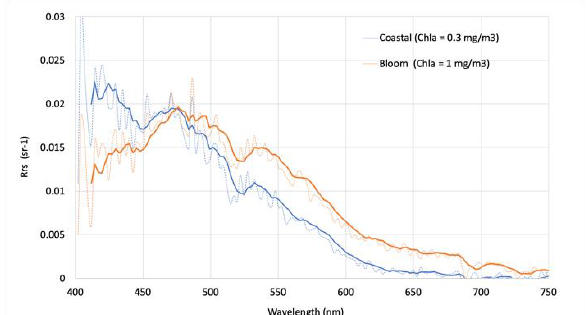
Figure 9 . True colour composite of DESIS Level 1 (left) and the retrieved chlorophyll-a concentration (mg/m 3 ) with Polymer at the Lucinda AERONET-OC study region for DESIS and S2- Figure 6 . True colour composite of DESIS Level (left) and the MSI in 25.12.2019. Grey and white regions are masked as in retrieved chlorophyll-a concentration (mg/m 3 ) with Polymer at Figure 3. the Galata AERONET-OC study region in 13.02.2020. Grey and white regions are masked as in Figure 3. Black dots indicate A quick comparison of the Rrs spectra of DESIS and S2-B the position of the normalized water leaving reflectance reveled larger differences at the blue bands (443 and 490 nm) and spectrum shown in Figure 7. better agreement at the station in “ocean” than in the “channel” (Figure 10).